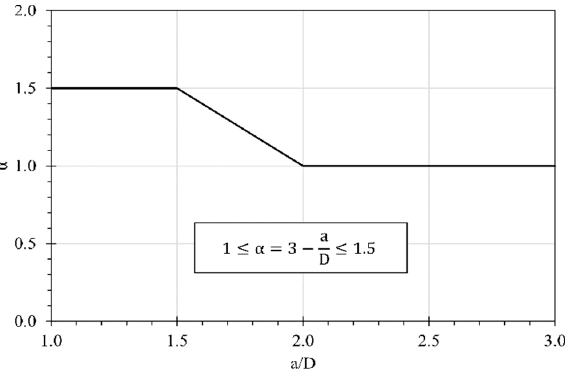
Figure 7. The factor α after Kowalsky and Priestley [30] (in Equation (14)).